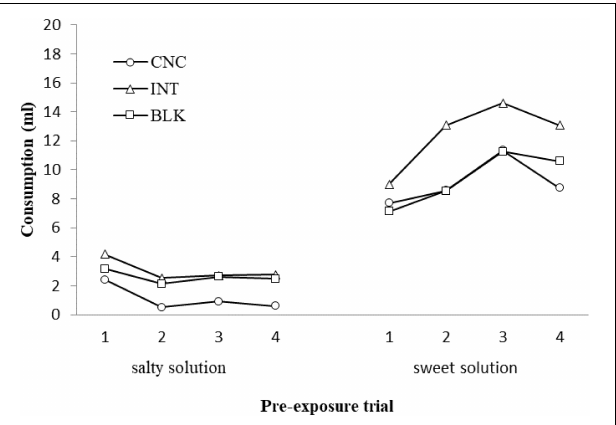
FIGURE 1 | Consumption (ml) of the salty and sweet solutions for the concurrent, intermixed, and blocked pre-exposure conditions across blocks of pre-exposure trials in Experiment